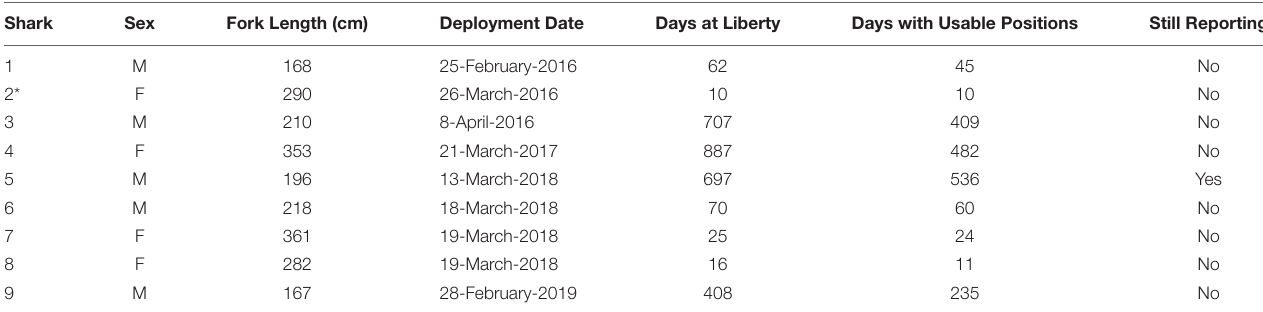
TABLE 1 | Tagging information for shortfin makos tagged in the northwestern Gulf of Mexico, including size at tagging, tracking duration, days with usable detections, and status of SPOT tag at the conclusion of the study.